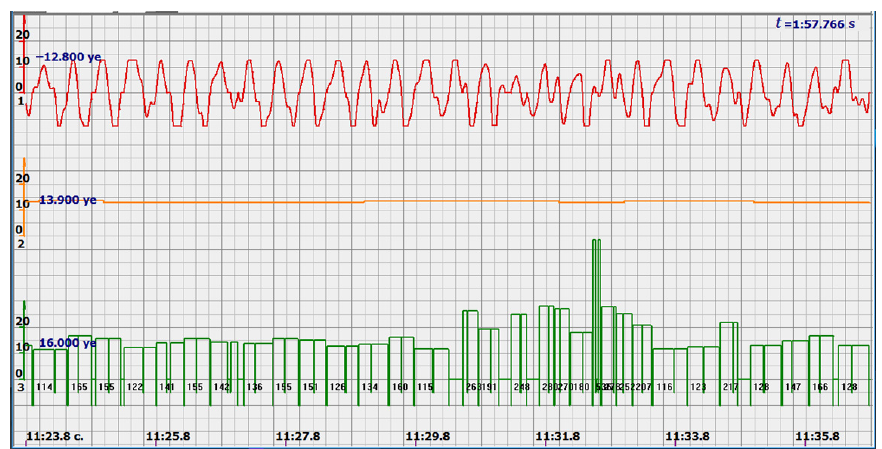
Figure 12. diagram during fetal movement.